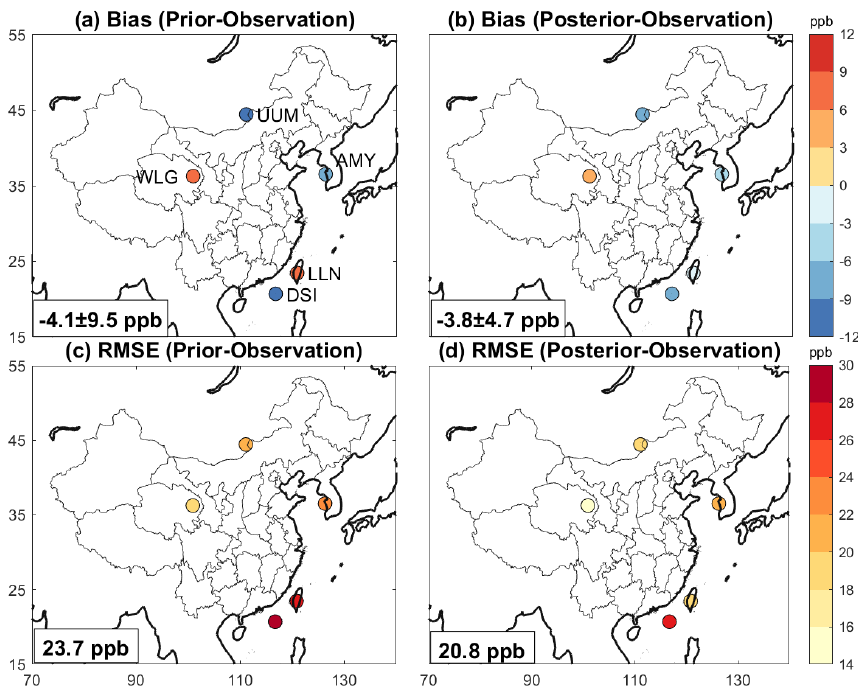
Figure 5. Comparison of GEOS-Chem simulations of atmospheric methane concentrations to in situ observations from five surface sites in 2019 compiled in the NOAA GLOBALVIEWplus CH 4 ObsPack v4.0 database. The five sites are described in detail in Table S2. The annual mean GEOS-Chem model biases and root-mean-square errors (RMSEs) for individual near-weekly observations at each site are shown. The insets give spatial mean biases ± standard deviations for the ensemble of sites and corresponding RMSEs.